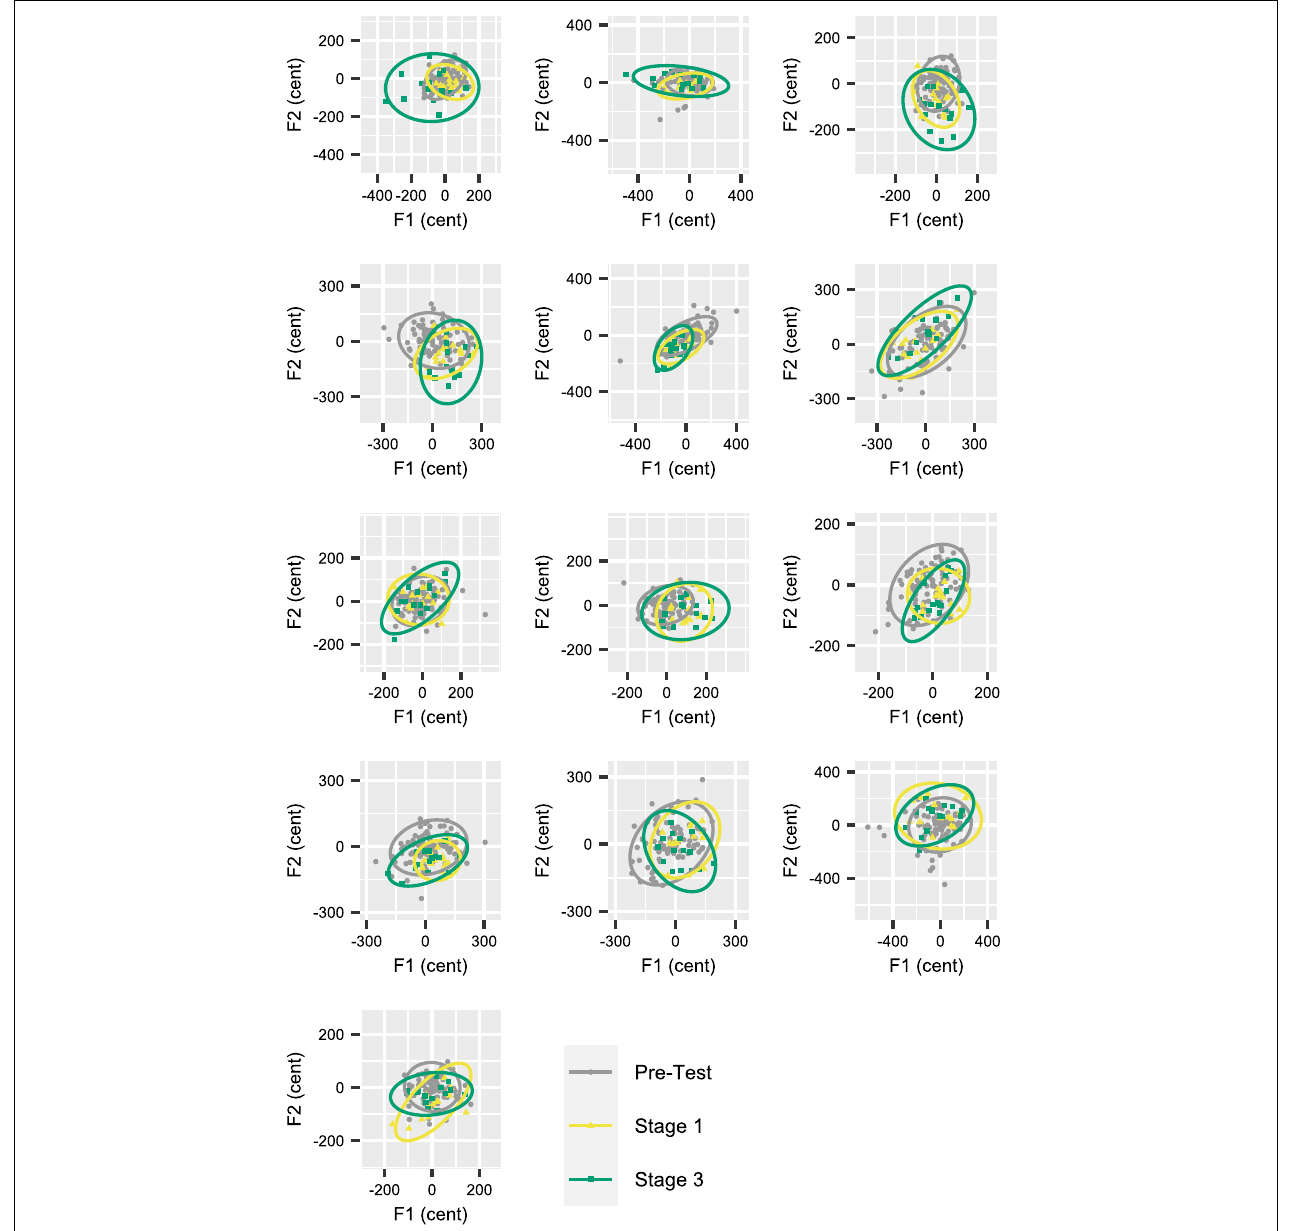
FIGURE 6 | Individual participant data (one participant per panel) for inter-trial formant dispersion in acoustic vowel space (F1 by F2). Data based on 95% confidence ellipses, calculated for formant frequencies extracted from the initial portion of the vowels. Each participant’s data from Stages 1 and 3 (15 trials per stage) in the Attenuated feedback variability condition are shown together with their data from the Pre-test (90 trials). Nine of 13 participants increased ellipse area in Stage 3 as compared with Stage 1. Participants are ordered (by row) from greatest to smallest ellipse area